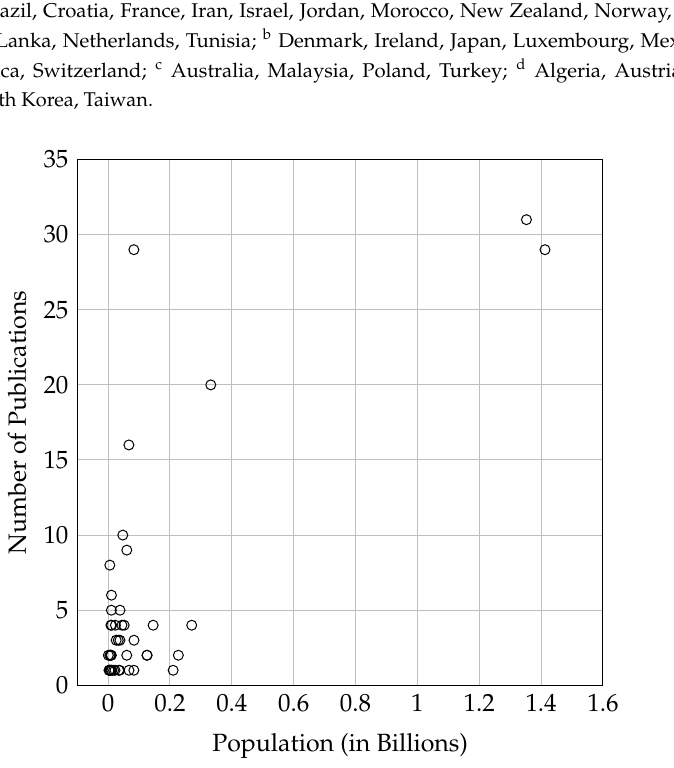
Figure 6. Comparison of number of publications and